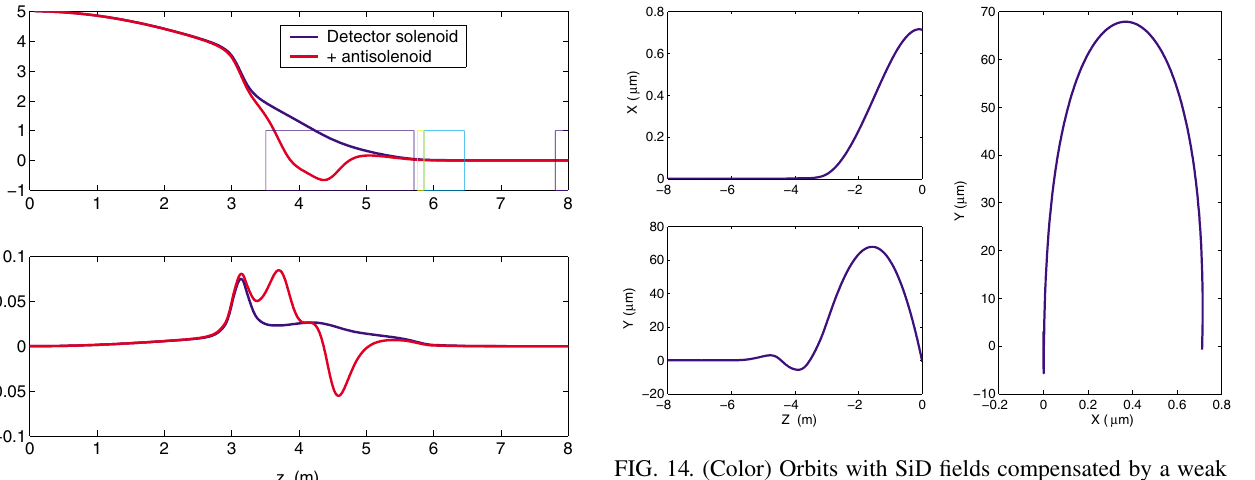
FIG. 14. (Color) Orbits with SiD fields compensated by a weak antisolenoid. IP is at z (cid:3) 0 m